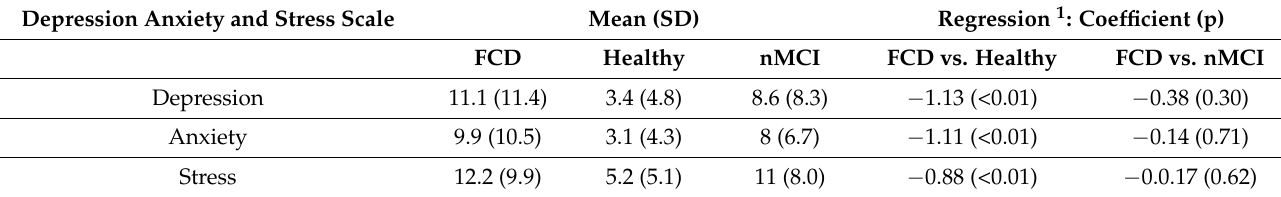
Table 2. Depression Anxiety and Stress Scale (DASS) per group.